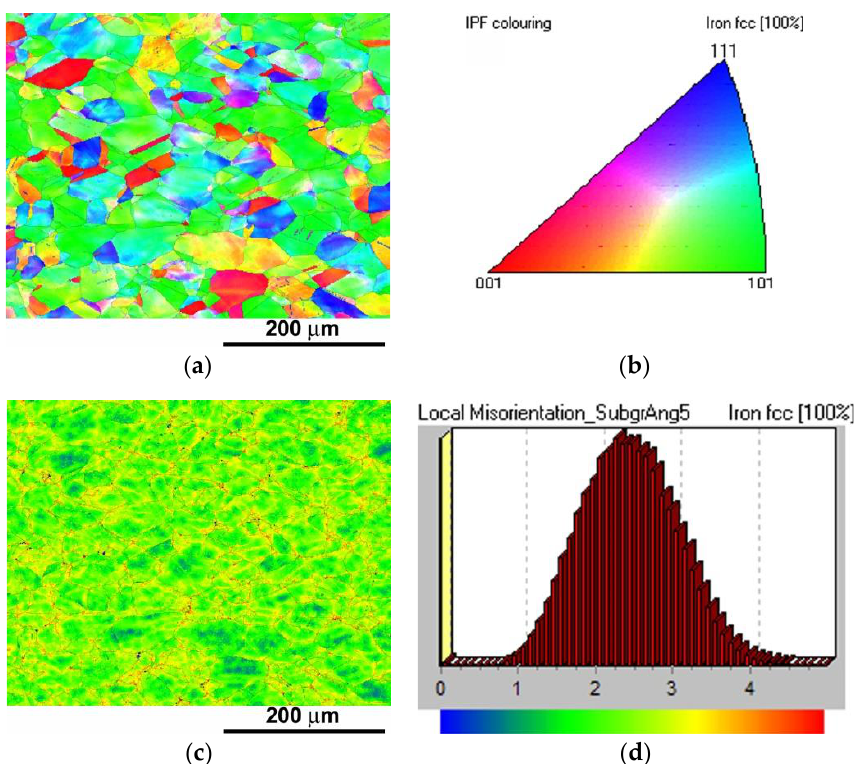
Figure 12. EBSD microstructure visualization of 38% plastically pre-strained 316H material: ( a ) inverse pole figure, ( b ) IPF color key, ( c ) local misorientation map, and ( d ) LMM legend.